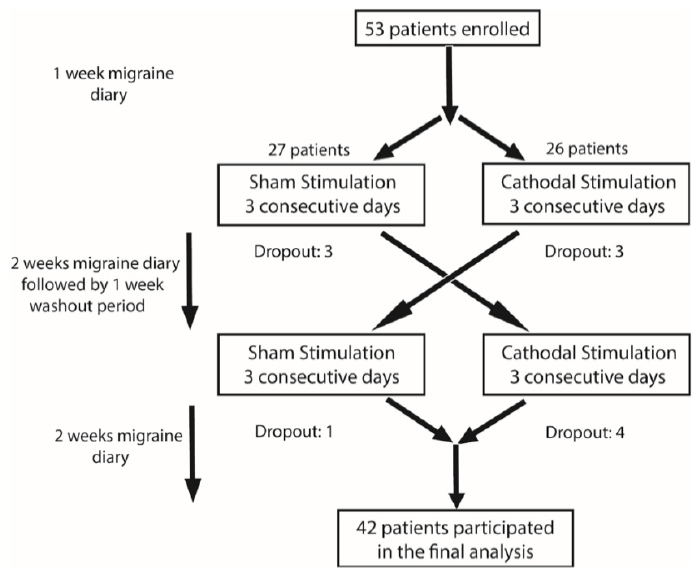
Figure 1. Schematic diagram summarizing the three phases of the study.